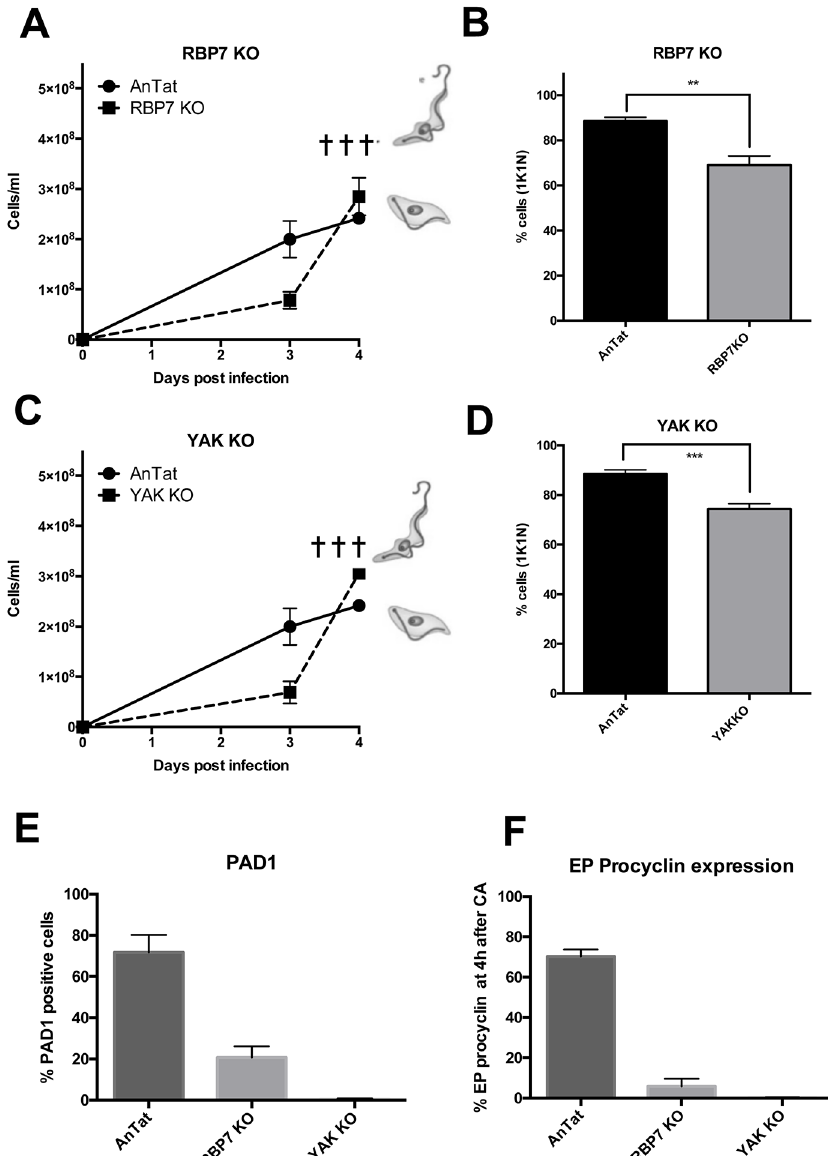
Fig 2. Null mutants for RBP7AB and YAK fail to differentiate to stumpy forms. A. Pleomorphic null mutants for RBP7AB were assayed for stumpy formation in vivo . The parasitaemia of the null mutants ( ■ ) increased without differentiation until the infections were terminated on humane grounds ( ✝ ). The parental T . brucei EATRO 1125 AnTat1.1 90:13 line ( ● ) showed reduced growth from day 3, and by day 4 of infection, were developing to intermediate and stumpy forms, this being represented schematically on the graph. Note that the relative growth of parental and null mutants cannot be directly compared, these being independent cell lines; the parental cells are included to show the progression from slender to stumpy forms in normal infections. B. %1K1N of cells on day 4 of infection for the parental (‘AnTat’) or the RBP7AB null mutant line. (cid:3)(cid:3) P < 0.005 GLM and Tukey test for multiple comparisons. C. Pleomorphic null mutants for YAK were assayed for stumpy formation in vivo .The parasitaemia of the null mutants ( ■ ) increased without differentiation until the infections were terminated on humane grounds ( ✝ ). The parental T . brucei EATRO 1125 AnTat1.1 90:13 line ( ● ) showed reduced growth from day 3, and by day 4 of infection, were developing to intermediate and stumpy forms, this being represented schematically on the graph. Note that the relative growth of parental and null mutants cannot be directly compared, these being independent cell lines; the parental cells are included to show the progression from slender to stumpy forms in normal infections. D. %1K1N of cells on day 4 of infection for the parental (‘AnTat’) or the YAK null mutant line. (cid:3)(cid:3)(cid:3) P < 0.0005 GLM and Tukey test for multiple comparisons. E. Cell lines harvested on day 4 of infection, assayed by flow cytometry for PAD1expression. F. Cell lines incubated in SDM-79 medium and exposed to 6mM cis aconitate (CA) after which they were assayed for EP Procyclin expression at 4 hours.